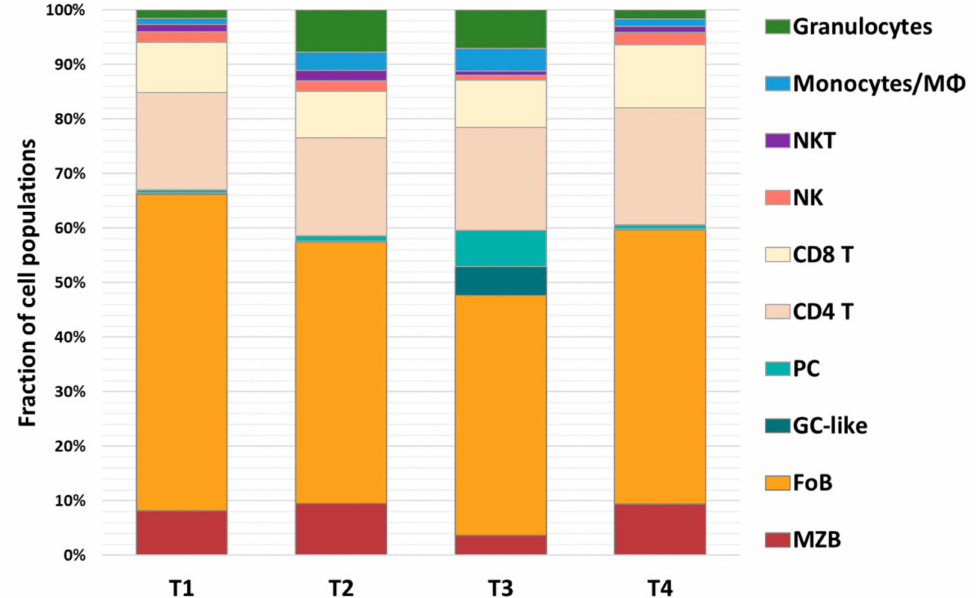
Figure 4. Early-stage T. b. brucei infection affects mainly the spleen B cell (reduction) and granulocyte (increase) numbers in DTPa-vaccinated mice. Numerical data, expressed as % value of the total spleen is plotted for marginal zone (MZB), follicular (FoB), germinal center-like (GC-like), and plasma B cells (PC), CD4+ and CD8+ T cells, NK1.1+ and NK1.1+TcR β + (NKT) spleen cells, and the monocyte/macrophage (M ϕ ) compartment as well as the spleen granulocyte population. Analysis was done for spleens of naïve mice (T1), DTPa-vaccinated mice prior to parasite challenge (T2), DTPa-vaccinated T. b. brucei AnTat 1.1-infected mice (T3), and DTPa-vaccinated T. b. brucei AnTat 1.1 challenged and cured mice (T4).